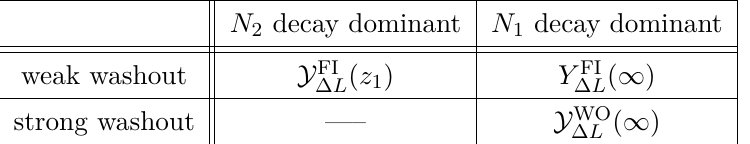
Table 1 . Four possible patterns of dominant contributions to the lepton